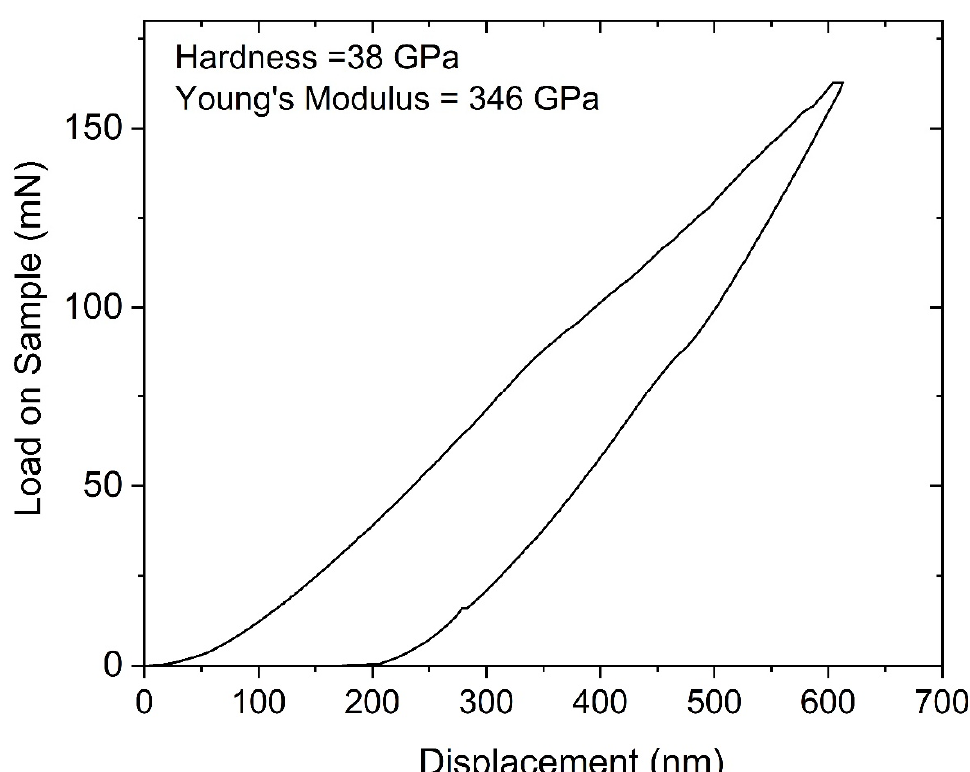
Figure 7. Nanoindentation load-displacement curve from one location on the boron-rich boron carbide microstructure to a depth of 600 nm. The extracted values of nanoindentation hardness and Young’s modulus are also indicated.